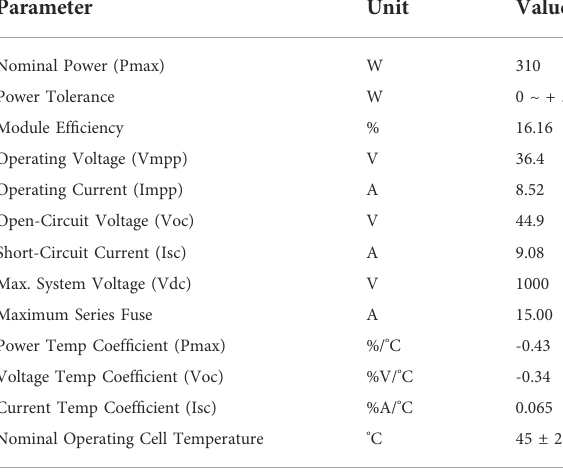
TABLE 4 Electrical characteristics of CS6X-310P-MaxPower PV